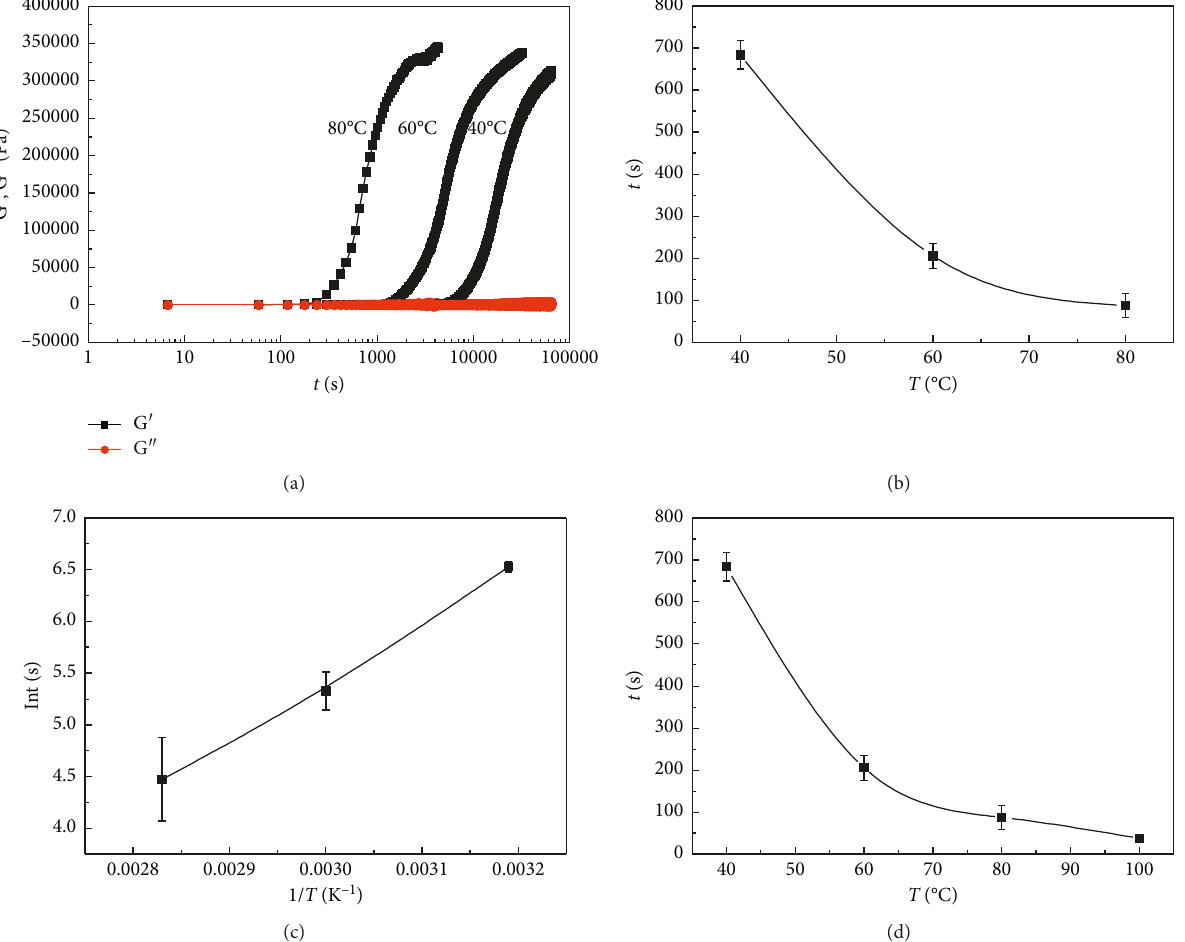
Figure 5: The data diagrams of rheological tests: (a) storage modulus (G time at each temperature, (c) the relationship curve obtained from Flory’s gel theory, and (d) the relationship between experimental and theoretical gelation time and